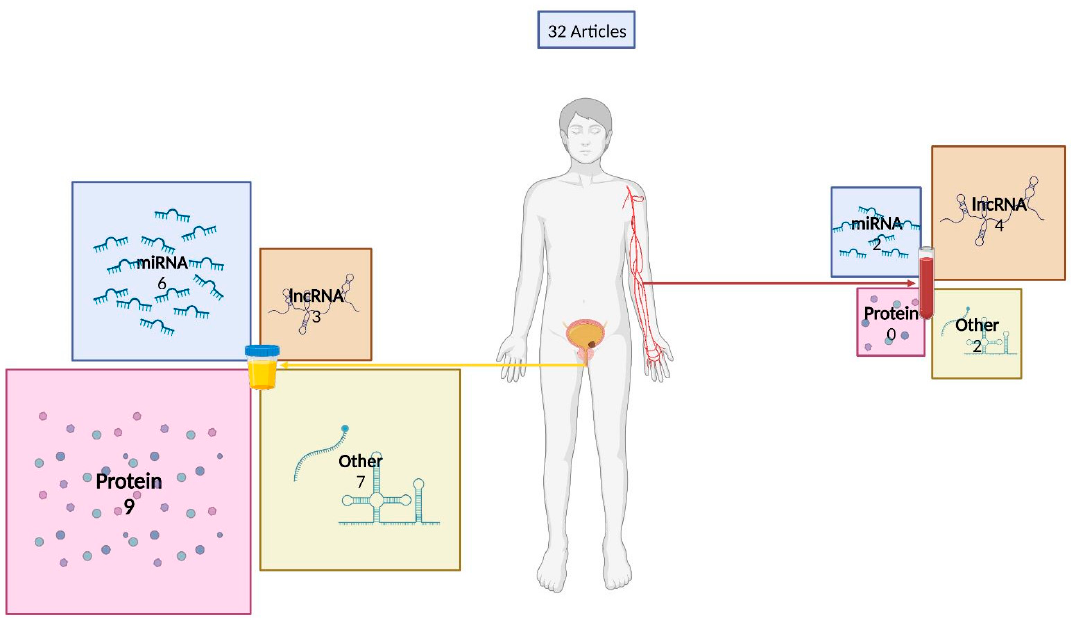
Figure 2. Distribution of extracellular-vesicle-derived bladder cancer biomarkers within urine and plasma/serum biofluids. Numbers represent the number of BC-EV biomarker studies. Created with BioRender.com.